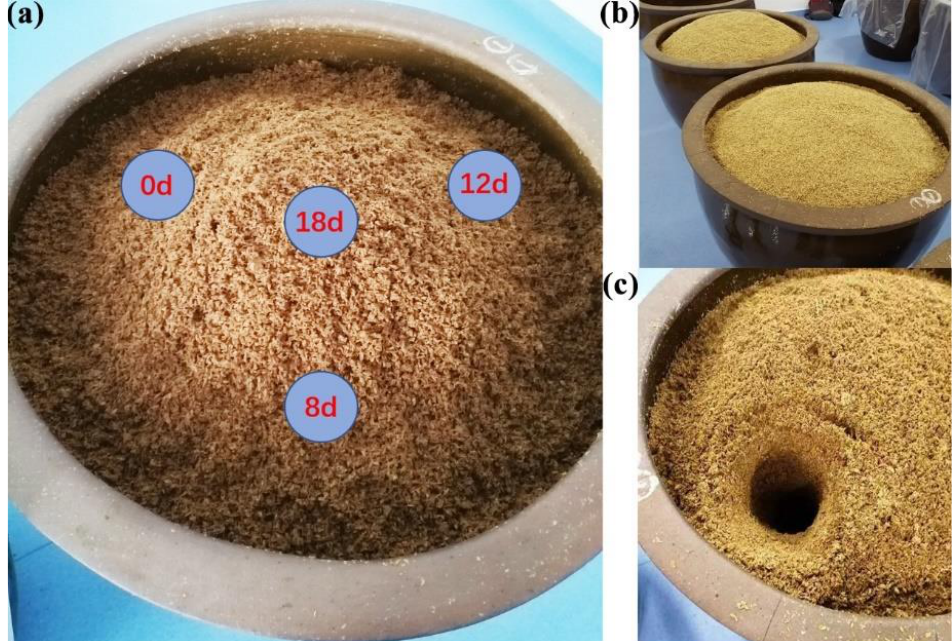
Figure 1. Vinegar Pei sample points distributed in the ceramic vat. ( a ) The 0th, 8th, 12th sample points were distributed at the tri-sector (about 15 cm from the wall) of the ceramic vat. The 18th was distributed at the center of the ceramic vat. ( b ) There were three biological replicates for each sample point. ( c ) In every sampling station, vinegar Pei from top to bottom in ceramic vat were took out and well mixed.